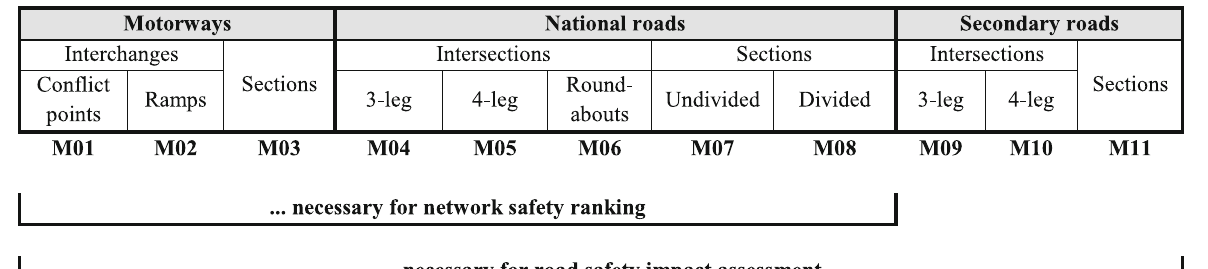
Table 1 Overview of categorization into 11 road network element